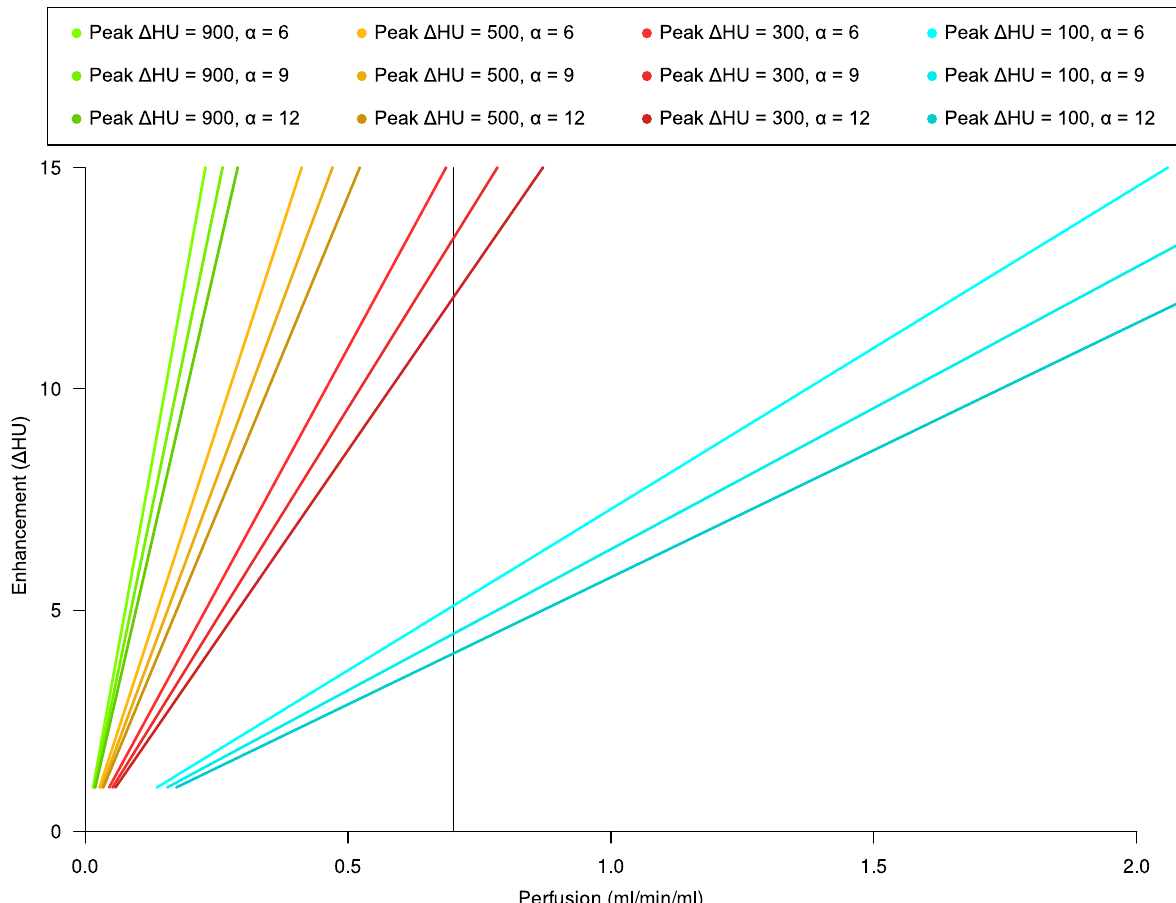
Fig. 5 Relationship between peak arterial phase tissue enhancement (ΔHU) and organ perfusion (mL/s/mL) in the brain for different peak feeding vessel enhancements and α parameters. Due to the effect of the blood–brain barrier and to the lack of an interstitial phase, we have a very short t max (approximately 9 s). The average perfusion value for the grey matter (indicated by the black vertical line) would be 0.72 mL/min/mL (range 0.64–0.84